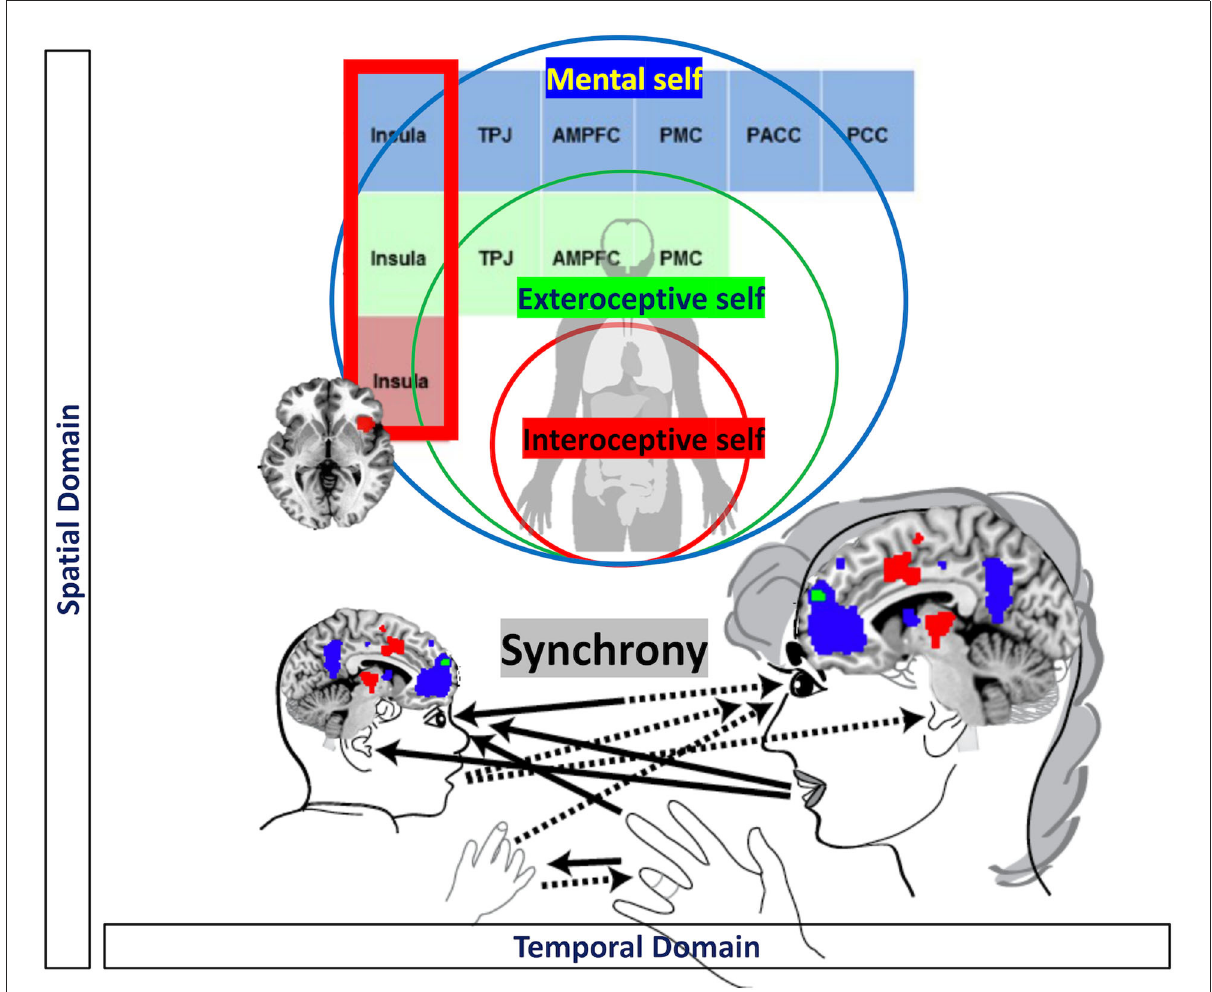
FIGURE5 The role of anterior insula in biobehavioral synchronization between caregiver and child and in the nested hierarchical model of